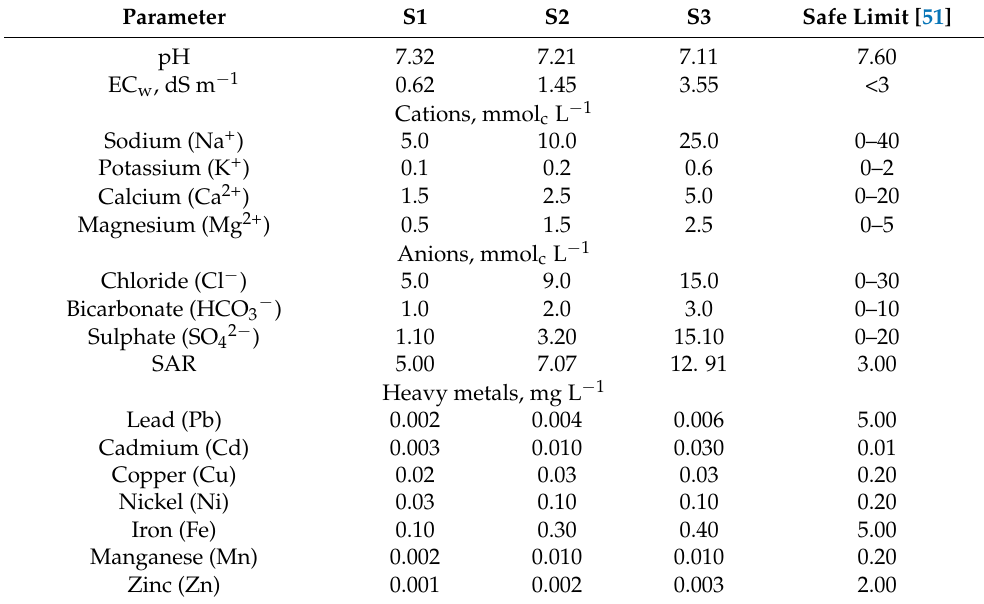
Table 1. Average values of physico-chemical parameters and concentration of heavy metals in irrigation water